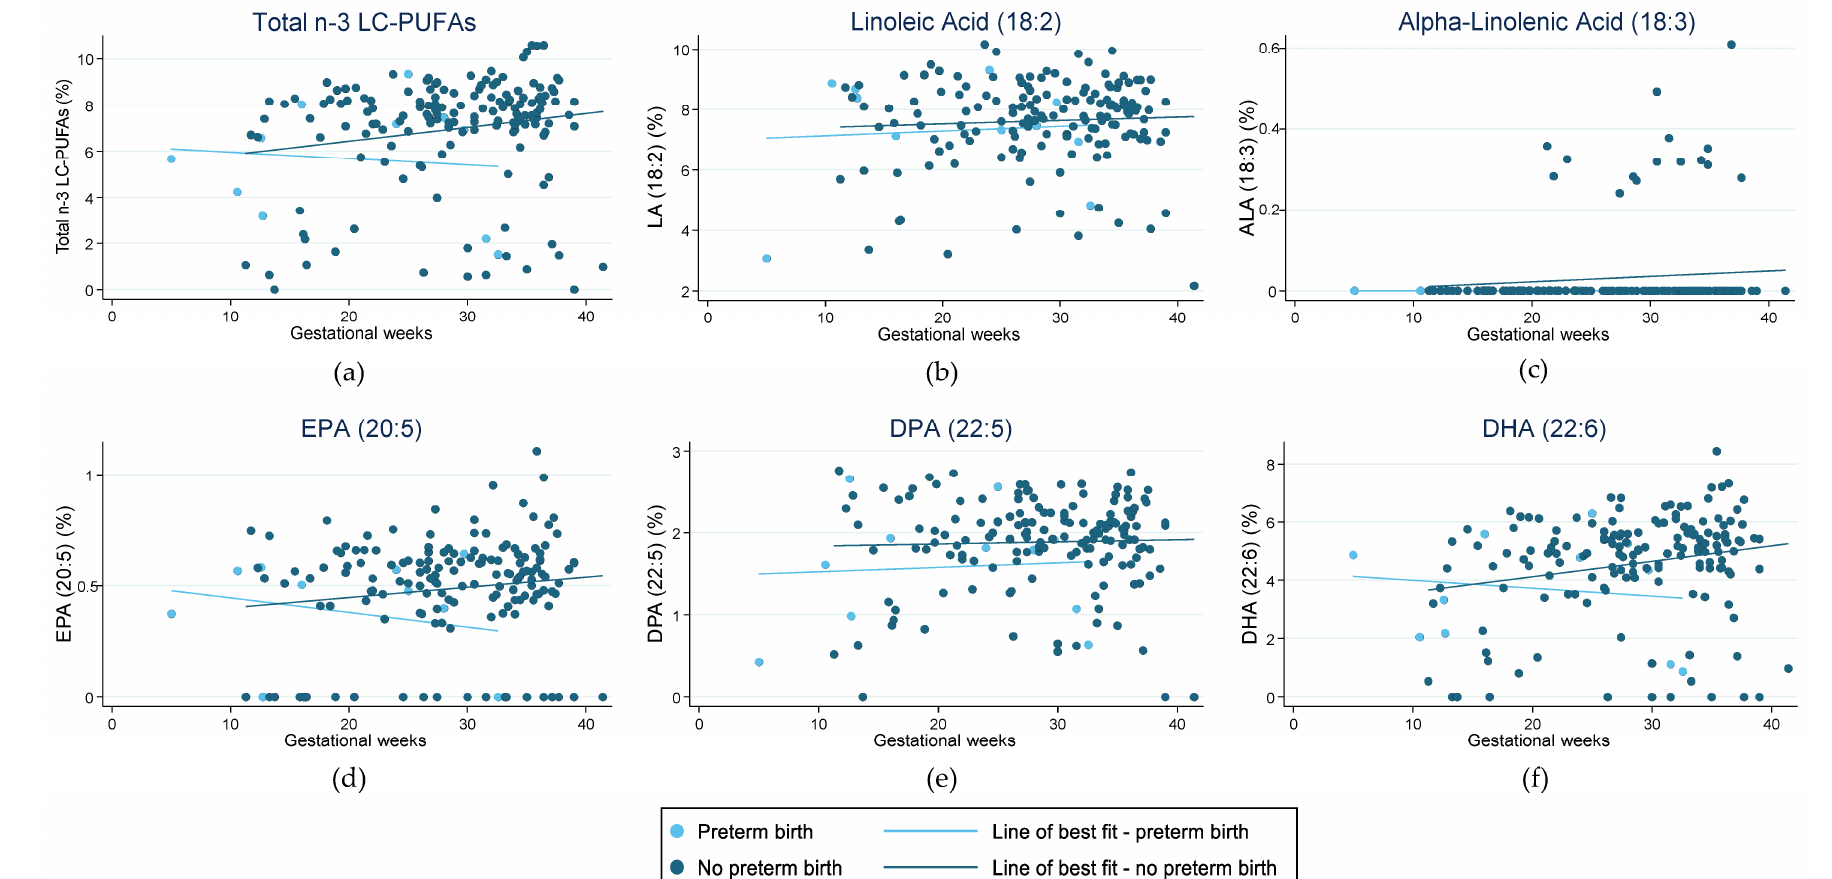
Figure 1. Fraction of LC-PUFAs (long-chain polyunsaturated fatty acids) in red blood cell membranes in pregnant women from the Gomeroi Gaaynggal cohort and those who experienced preterm birth: ( a ) Fraction of total n -3 LC-PUFAs (Omega-3 long-chain polyunsaturated fatty acids) (EPA, DPA and DHA); ( b ) Fraction of linoleic acid (18:2); ( c ) Fraction of alpha-linolenic acid (18:3); ( d ) Fraction of EPA (eicosapentaenoic acid) (20:5); ( e ) Fraction of DPA (docosapentaenoic acid) (22:5); ( f ) Fraction of DHA (docosahexaenoic acid) (22:6).